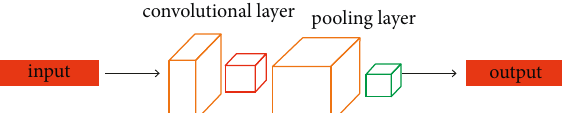
Figure 2: The workflow of the CNN